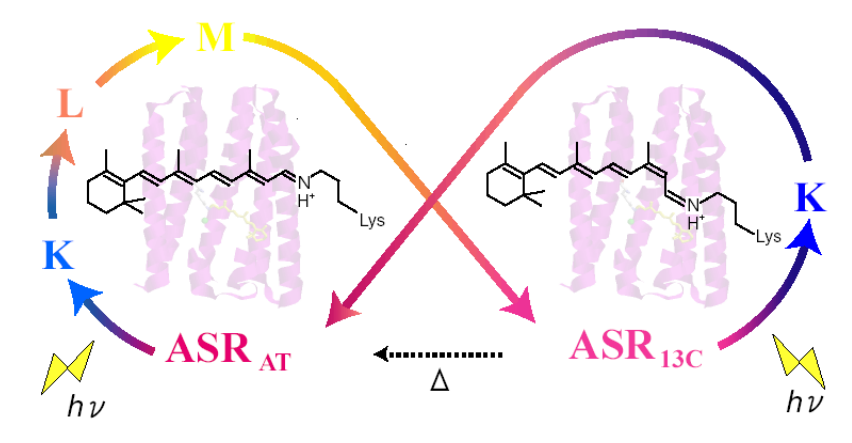
Figure 30. The photoreaction of ASR. Both isomers (ASR yield to another isomer, respectively. This figure is reprinted with permission from Kawanabe et al. [71]. Copyright 2007 American Chemical